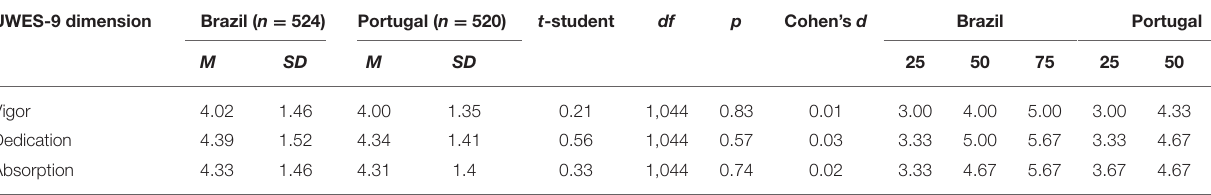
TABLE 8 | Comparative analysis between countries (means, SD and percentiles). UWES-9